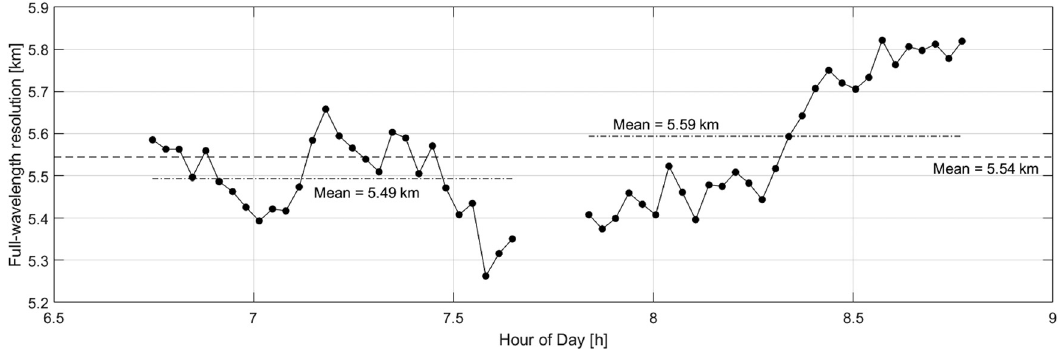
Figure 7: Derived spatial resolution along the two line pro fi les. Also shown is the mean value of 5.54 km for both passes and mean values of 5.49 and 5.59 km for the fi rst and second pass,